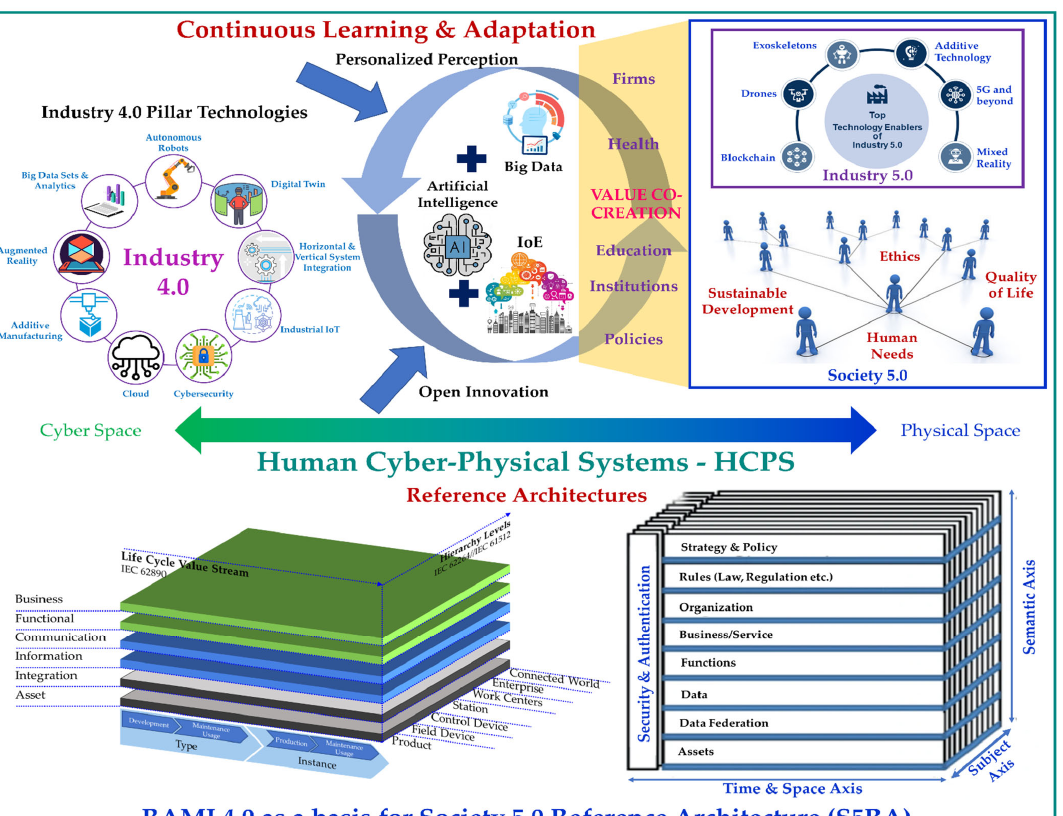
Figure 14. Industry 5.0 and Society 5.0 conceptual framework based on the integration of Industry 4.0 reference architecture model and technologies.